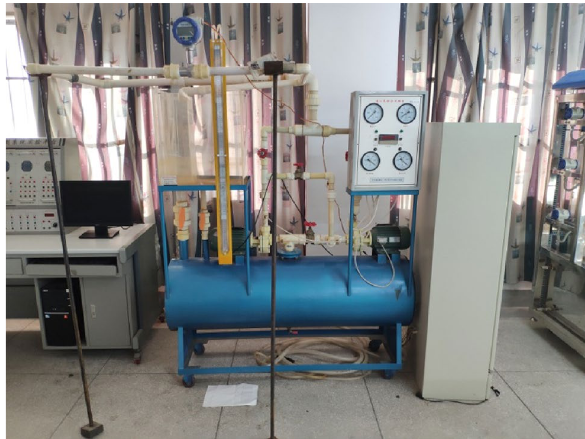
Figure 5. Flow control test